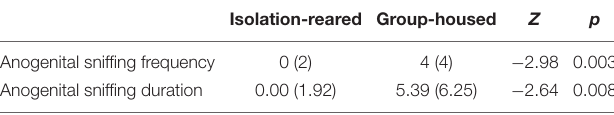
TABLE 1 | Social interaction of isolation-reared and group-housed mice. TABLE 2 | Homosexual behavior of isolation-reared and group-housed mice.